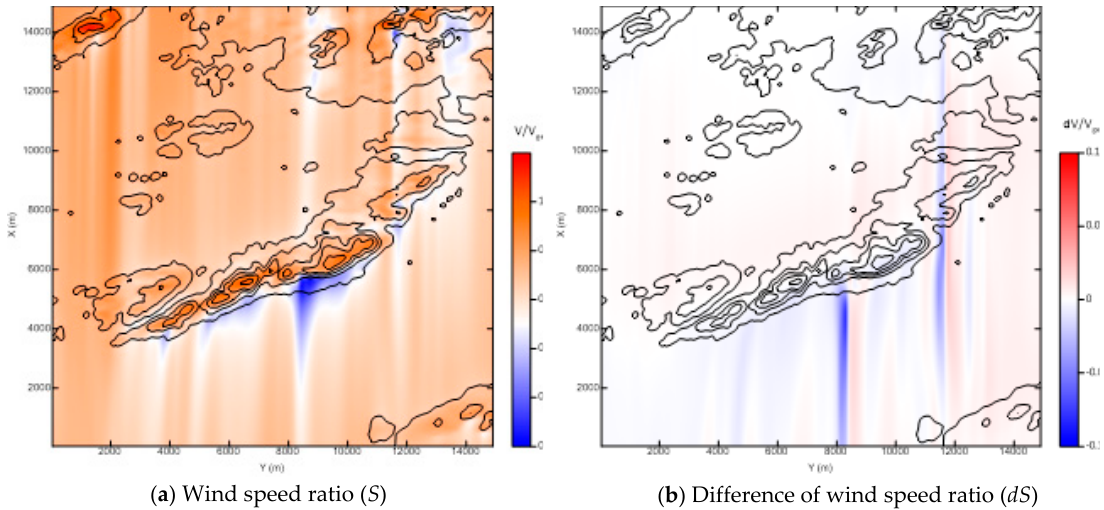
Figure 3. Contour plots of wind speed ratio for the northerly wind case (5 m above ground level).